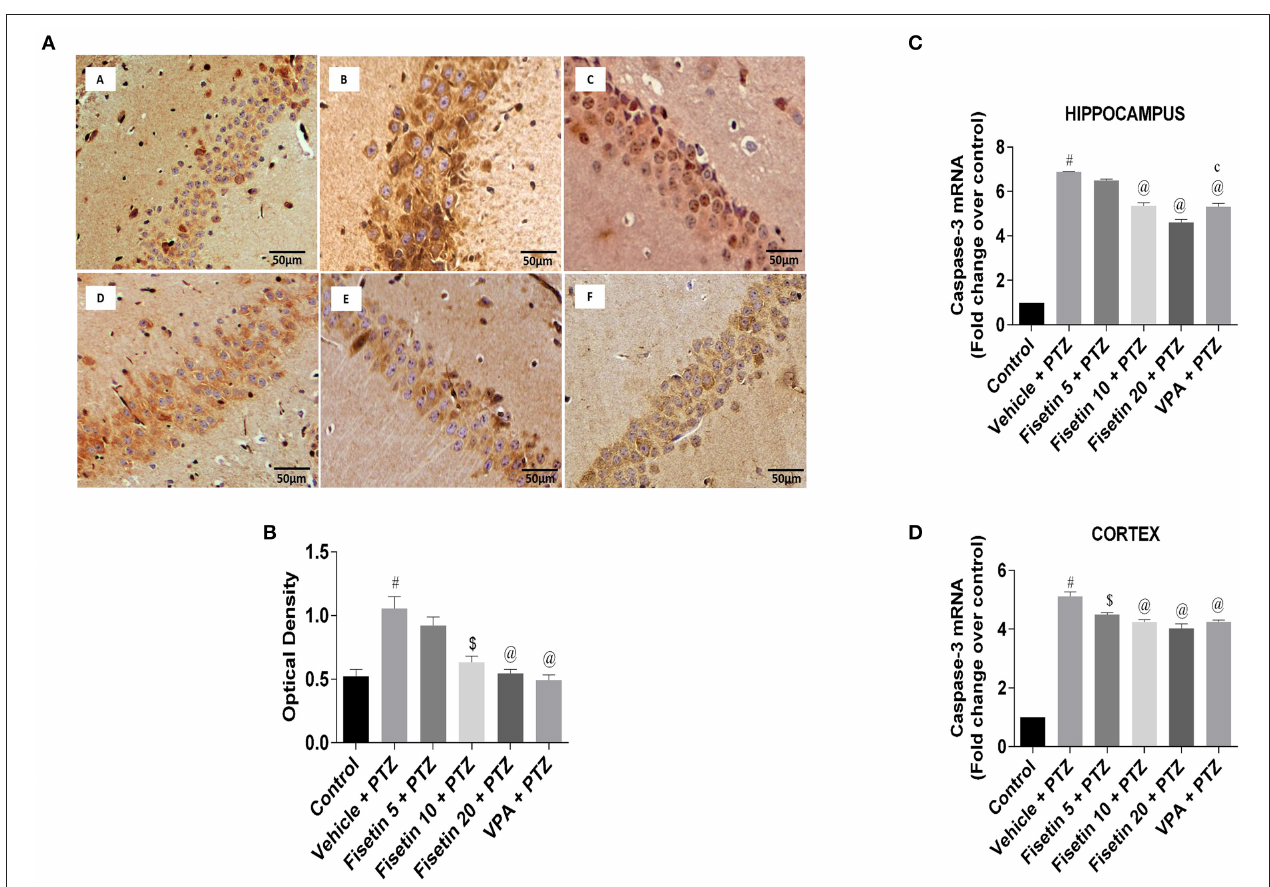
FIGURE 9 | Effect of fisetin administration on apoptosis marker, caspase-3 in kindled mice. (A) Photomicrographs of the hippocampus in different experimental groups are shown (40X). (A) Control, (B) vehicle + PTZ, (C) fisetin 5 + PTZ, (D) fisetin 10 + PTZ, (E) fisetin 20 + PTZ, and (F) VPA + PTZ. Fisetin administration resulted in reduced immunoreactivity of caspase-3 protein in pyramidal cells of the hippocampus compared with the vehicle + PTZ group. (B) Quantitative estimation of caspase-3 immunostaining ( n = 3). (C) mRNA expression of caspase-3 in the hippocampus ( n = 3). (D) mRNA expression of caspase-3 in the cortex ( n = 3). Data were analyzed by one-way ANOVA followed by Tukey’s multiple comparison test and expressed as mean ± SEM. # p < 0.001 as compared with control group; $ p < 0.01 as compared with vehicle + PTZ group; @ p < 0.001 as compared with vehicle + PTZ group, and c p < 0.01 as compared with fisetin 20 + PTZ